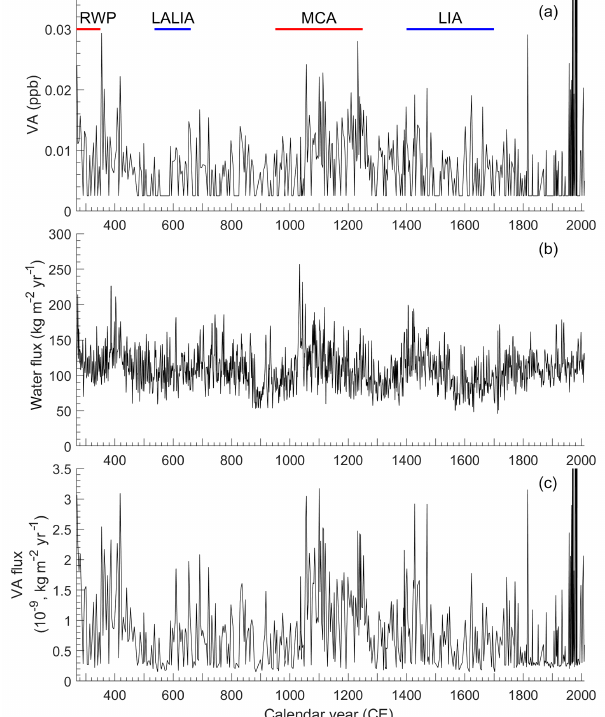
Figure 6. Tunu ice core vanillic acid concentration (a) , water accu- mulation flux (b) , and vanillic acid depositional flux (c) computed as the product of vanillic acid concentration and water accumula- tion flux. The horizontal lines at the top show the Roman Warm Period (RWP), Late Antique Little Ice Age (LALIA), Medieval Cli- mate Anomaly (MCA), and the Little Ice Age (LIA) (Büntgen et al., 2016; Mann et al., 2009; Wang et al., 2012). by changes in snow accumulation (Fig. 6). Excluding